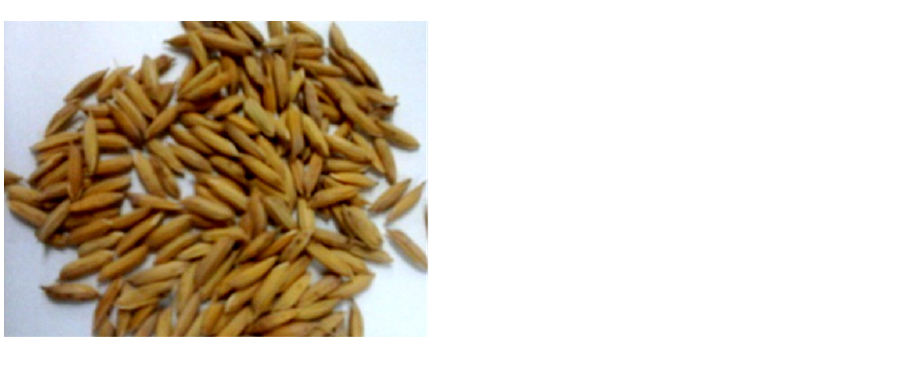
Figure 9. Rice grains after convective drying process at 60 °C (Mo = 34.5% dry basis, t = 960 min). Silva [48] reports on the influence of temperature on the final quality of paddy rice grain (BRSMG Conai variety) during the process of pure convective drying, in an oven with forced air circulation. According to the author, an increase in the index of cracks and breaks was detected in the dry rice grains at the drying air temperature of 70 ◦ C in relation to that obtained in the drying carried out with lower temperatures (40, 50 and 60 ◦ C) and severe cracks affect the germination of the rice grain and reduce the commercial price of this product.